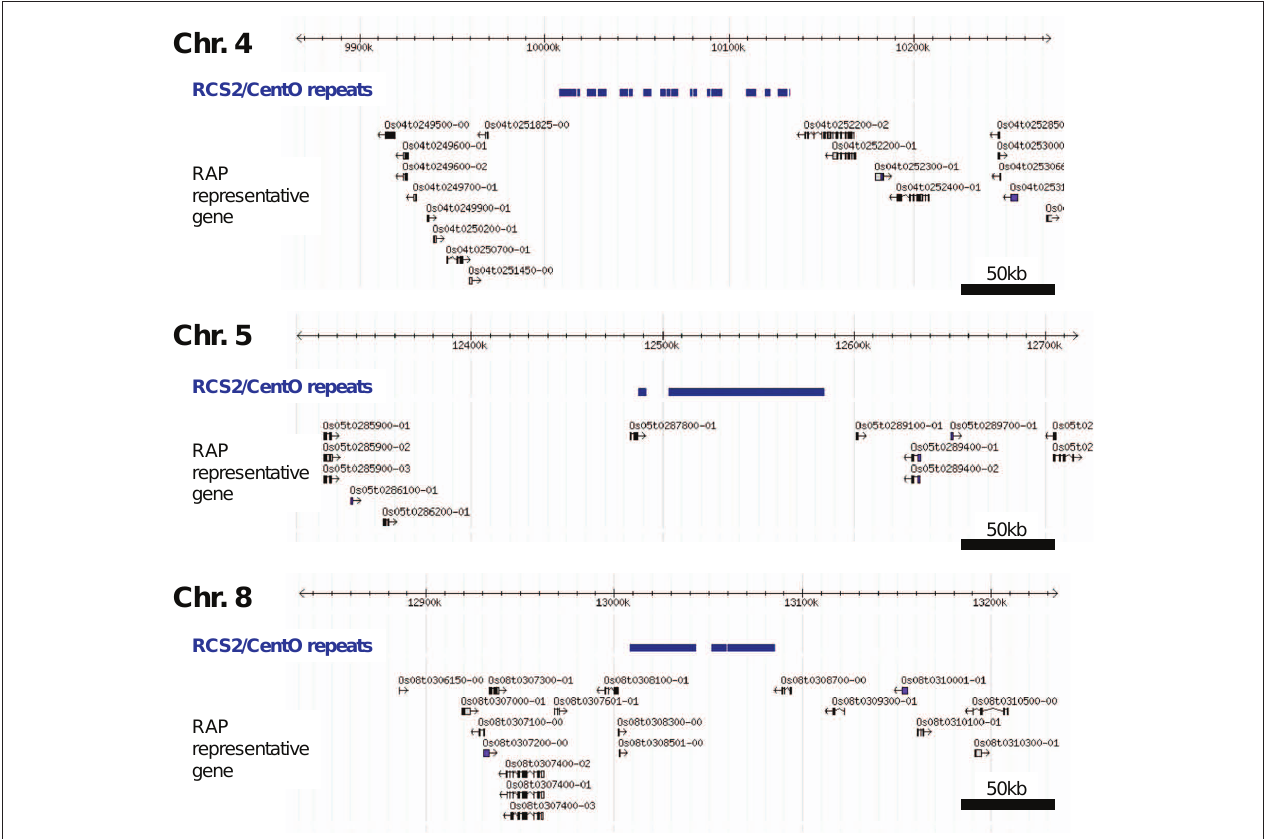
FIGuRe A2 | Distributions of RCS2/CentO clusters. RCS2/CentO clusters in Cen4, Cen5 , and Cen8 on rice genome sequence Build 5.0 (blue boxes) are shown. The small RCS2/CentO sequence in Cen8 ( Figure A1B in Appendix) is not shown. Gene models based on Rice Annotation Project (RAP) representative genes